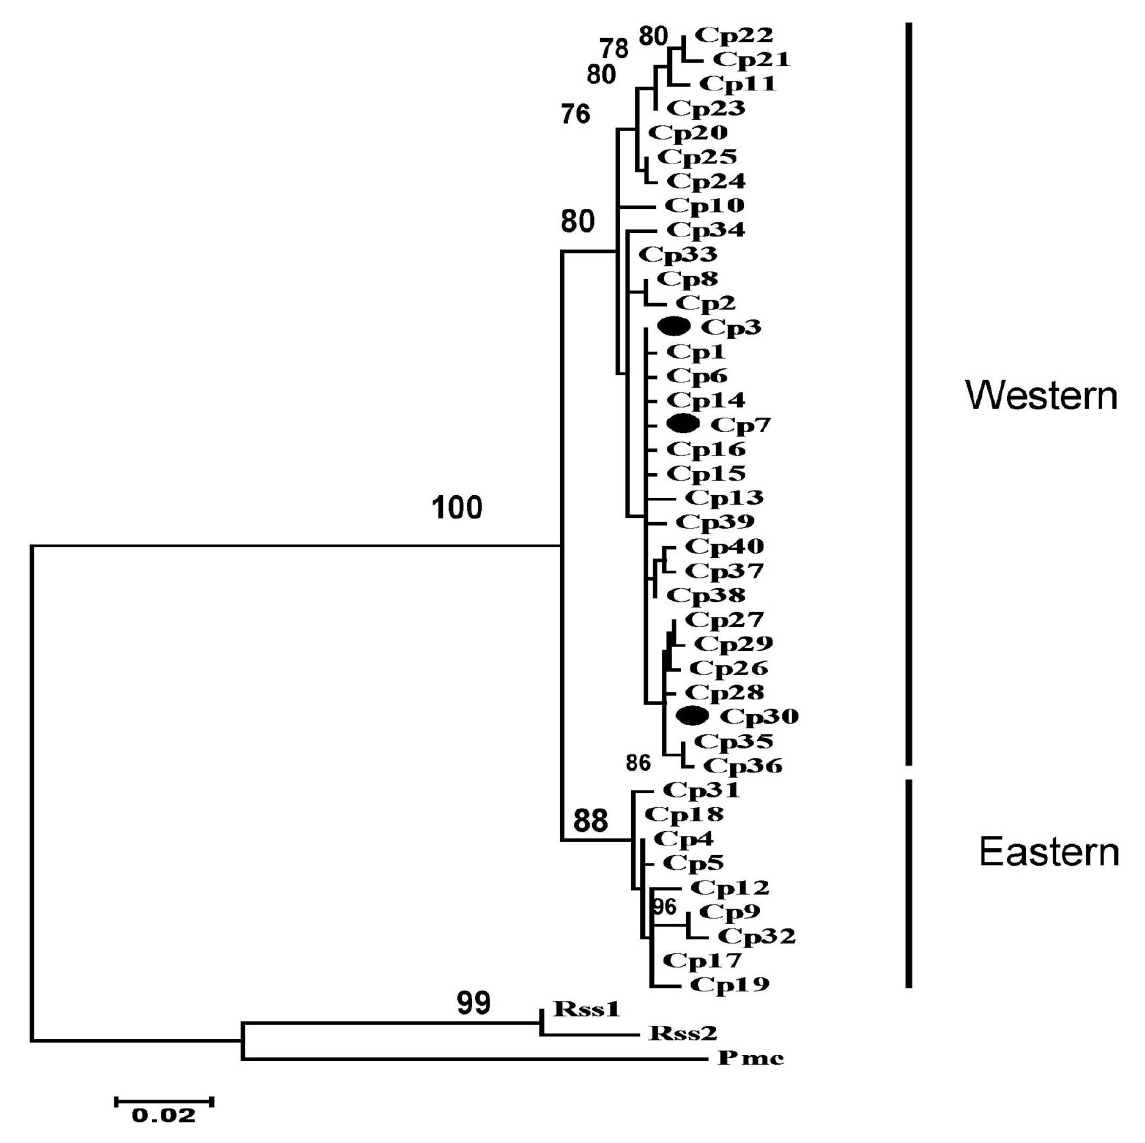
estimates were 0.522 and 6.66 million years ago, respectively). Under the expanding population scenario, the estimated mean TMRCA was 3.1 million years ago (lower and upper bounds of the 95% highest posterior density interval of estimates were 0.492 to 8.61 million years ago, respectively). Figure 1. Phylogenetic relationships among 40 cytochrome b mitochondrial DNA haplotypes of lake chub ( Couesius plumbeus , Cp1-40) and selected outgroup taxa as estimated by Maximum-likelihood clustering of sequence divergence estimates (HKY+ G distance). Numbers at branch points represent bootstrap support levels (N = 1,000 pseudoreplicates). Haplotypes accompanied by closed ovals represent fish both from Atlin Warmspring and Liard Hotsprings. Haplotypes that define the ―western‖ and ―eastern‖ lineages are denoted by the thick vertical bars. Rss = reside shiner ( Richardsonius balteatus ), Pmc = Peamouth chub ( Mylocheilus caurinus )